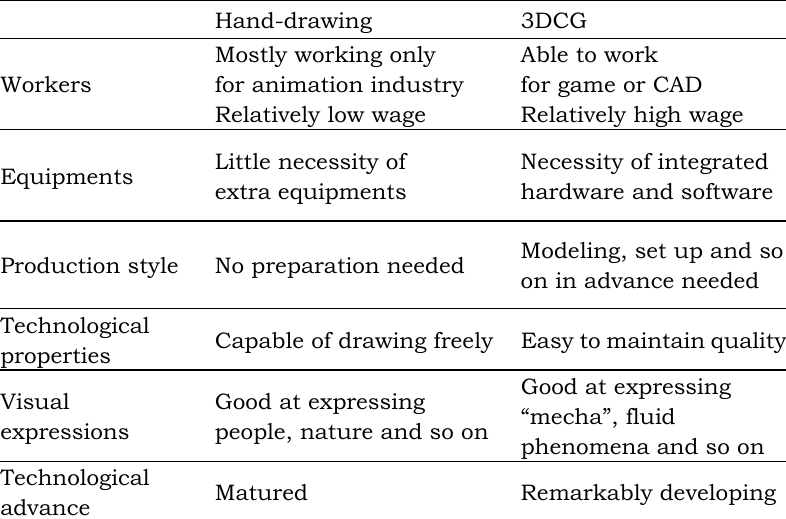
Table 1. The difference between hand-drawing (established technology) and 3DCG (new